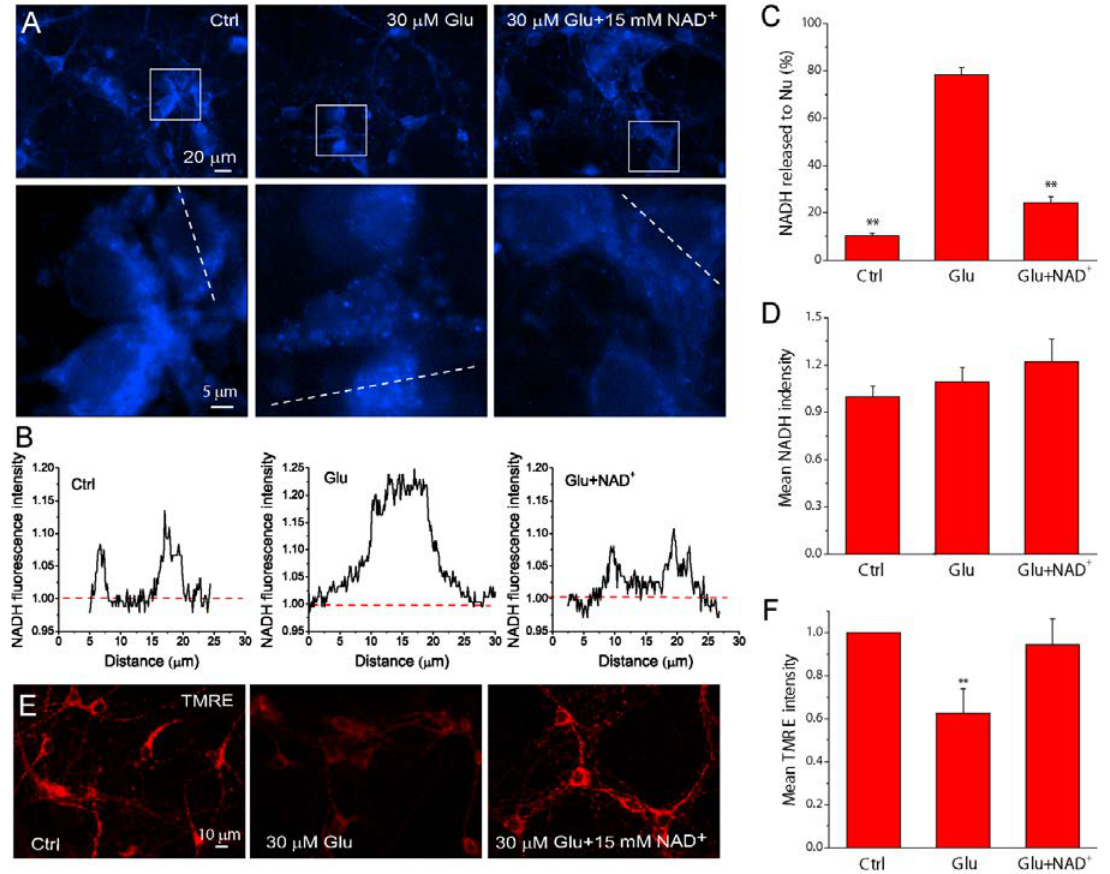
Figure 6. NAD + preserves mitochondrial functional integrity after glutamate excitotoxicity. ( A ) Representative images of NADH auto-fluorescence under different conditions using fluorescence microscopy. The lower panels are the high resolution images of the boxed region in upper panels; ( B ) Line-scan of NADPH fluorescence from neurons indicated in ( A ), showing the localization of NADPH under different condition. The fluorescence was normalized to the background. Notice from ( A , B ) that glutamate stimulation caused NADH release from mitochondria and the concentration of NADPH in the nuclei; ( C , D ) The percentage of neurons with NADH localized in nuclei ( C ) and the average fluorescence intensity normalized with cell number in the field ( D ) under different conditions; ( E , F ) TMRE images of neurons (E ) and the average fluorescence intensity normalized with cell number ( F ) with different treatments. The reduction of TMRE fluorescence indicated the loss of